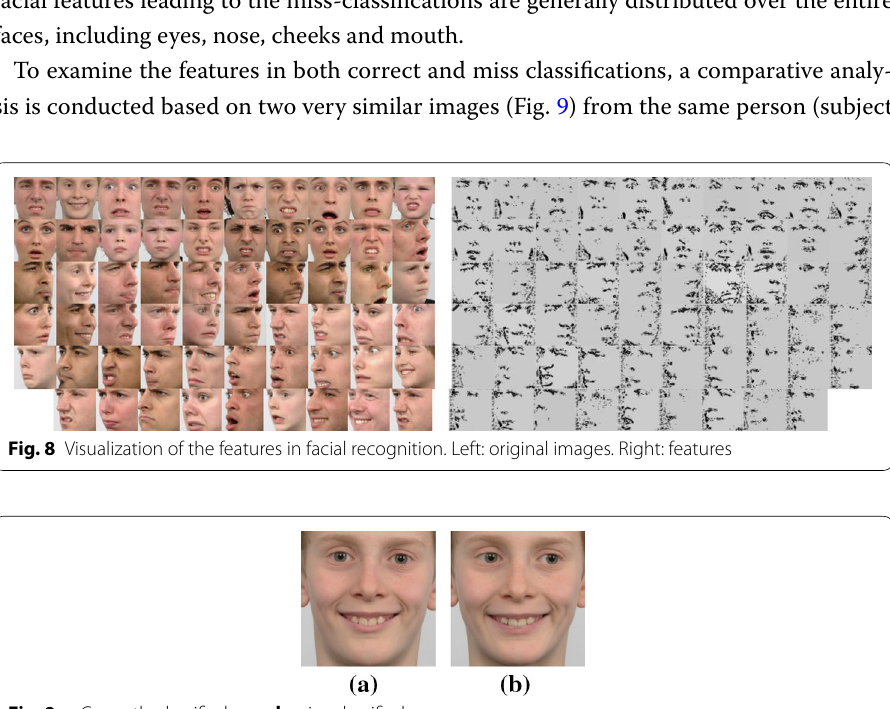
Fig. 9 a Correctly classified case; b miss-classified